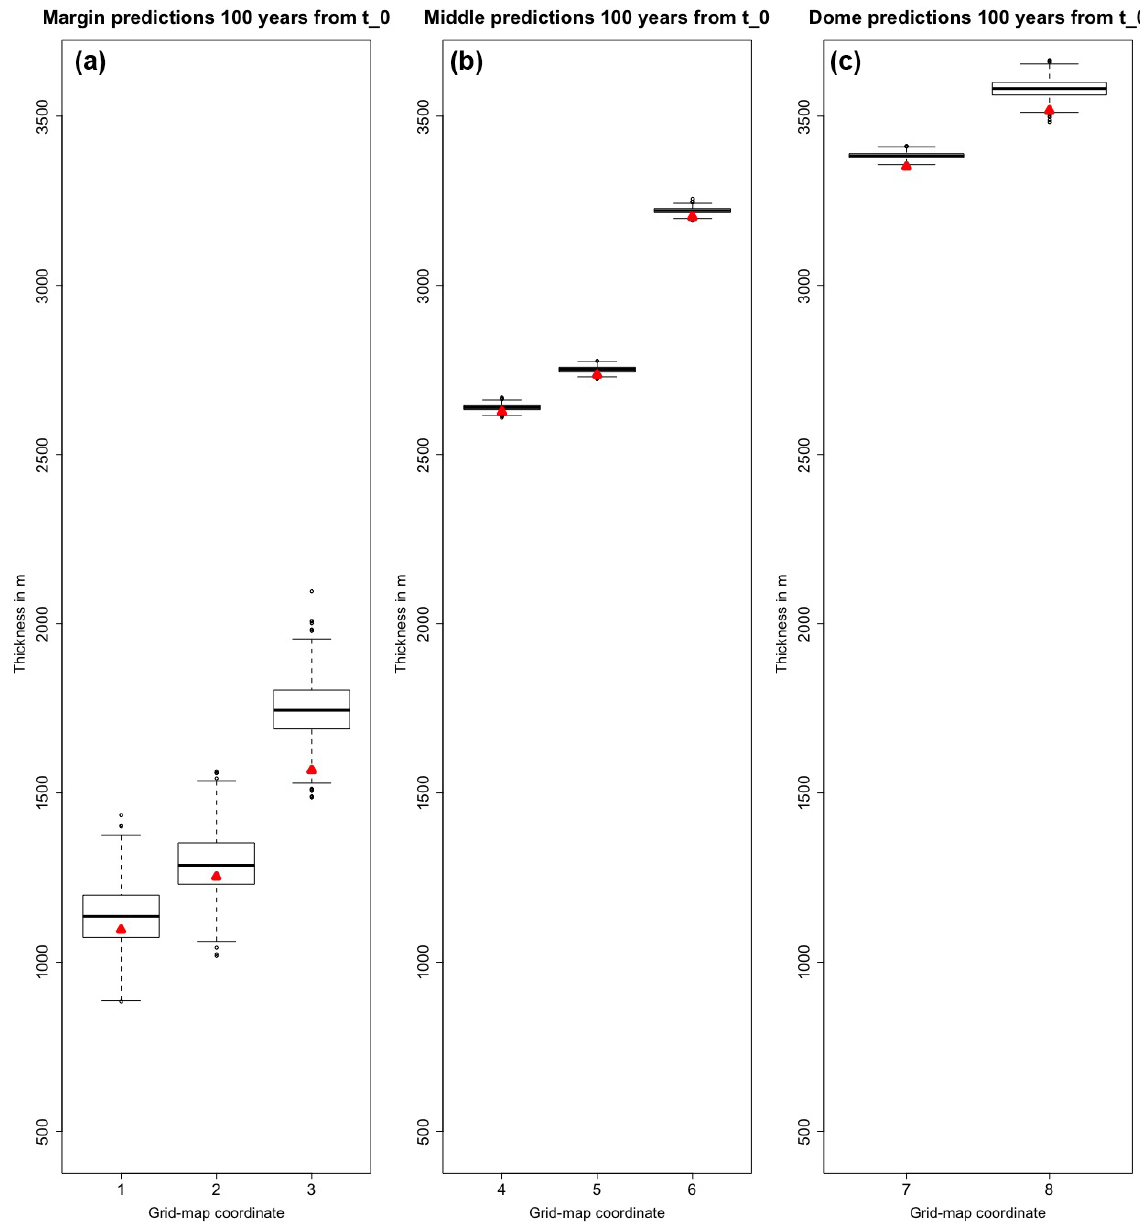
Figure 6. Thickness prediction samples 100 years from t 0 for test case B (i.e., no mass balance field or basal sliding). Triangles indicate the actual thickness values from the analytical solution. Panel (a) shows predictions that are close to the margin (red squares of Fig. 5), panel (b) shows predictions that are between the dome and margin of the glacier (blue squares of Fig. 5), and panel (c) shows predictions that are towards the dome of the glacier (black squares of Fig. 5). Refer to Fig. 5 for a grid map to spatially reference each of the box plots. As can be expected according to Bueler et al. (2005), the largest errors occur at the dome and the margin. Note on interpretation: the middle of each box is the median, the interquartile range is denoted by the box, and 1.5 of the interquartile range beyond the first and third quartile is illustrated with the whiskers. Those points that are more than 1.5 of the interquartile range beyond the first and third quartiles are outliers, and they are denoted with